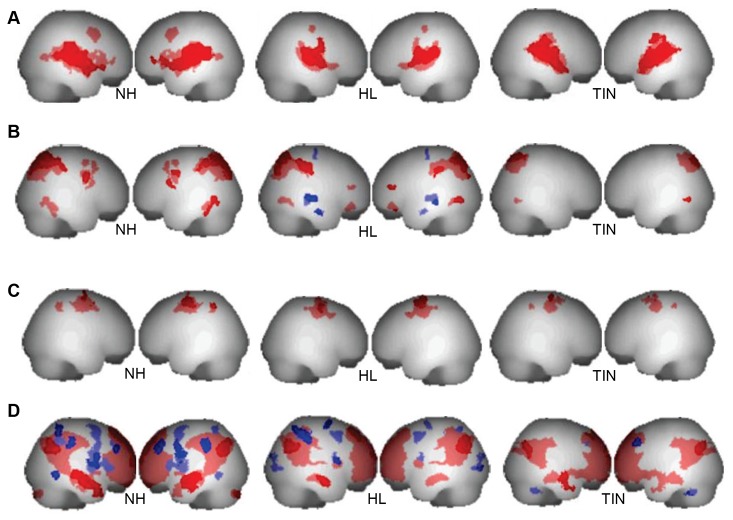
Correlation maps of seed regions for each network.Correlations shown are p<0.05 FDR corrected significant at the voxel and/or cluster level. Red represents positive correlations with seeds, while blue shows negative correlations.
A) Correlations with the seed regions in the auditory resting state network. Visually, there does not appear to be strong differences across groups, though the HL group shows slightly reduced connectivity when compared to the other two groups.
B) Correlations with the first pair of seeds in the dorsal attention network (DAN_1). There seems to be reduced correlations in the TIN group compared to the other two groups, as well as negative correlations that are exclusive to the HL group.
C) Correlations with the second pair of seeds in the dorsal attention network (DAN_2). Few differences can be noted across groups.
D) Correlations with the seed regions in the default mode network (DMN). Reduced connectivity (especially negative correlations) from the DMN seeds to other brain regions is seen in the TIN group when compared to the other two groups.